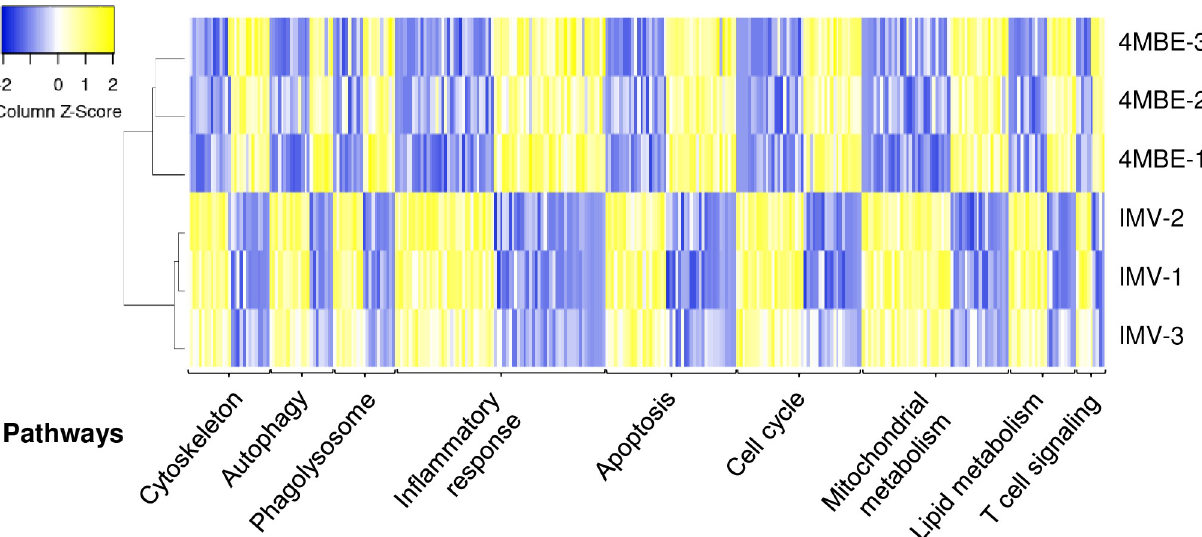
Fig 7. Dysregulation of macrophage gene expression upon infection by the 4MBE variant. Macrophages were infected at a MOI of 10:1 by the IMV or the 4MBE variant. At 24 hpi, total RNA were extracted to study the changes in global transcriptome of host cells. Heatmap of gene expression (log2 fold change) for 228 differentially expressed genes between IMV or 4MBE variant- infected macrophages at 24 hpi. Rows are independent experiments and columns are genes. Differentially expressed genes were classified in nine functional categories. Clustering was based on Pearson’s correlation. The two experimental conditions clustered with their biological replicates.